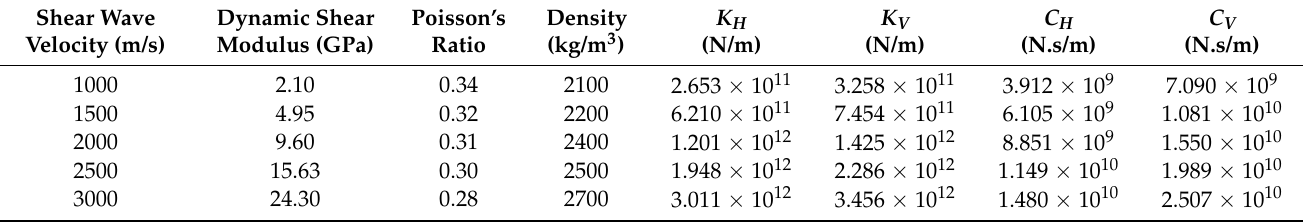
Table 1. Through Equations (5) and (6), the spring stiffness and damping coefficient assigned for each bottom node of the raft foundation can be obtained. Table 1. Material properties and the corresponding lumped spring stiffness and damping coefficient of different sites. Shear